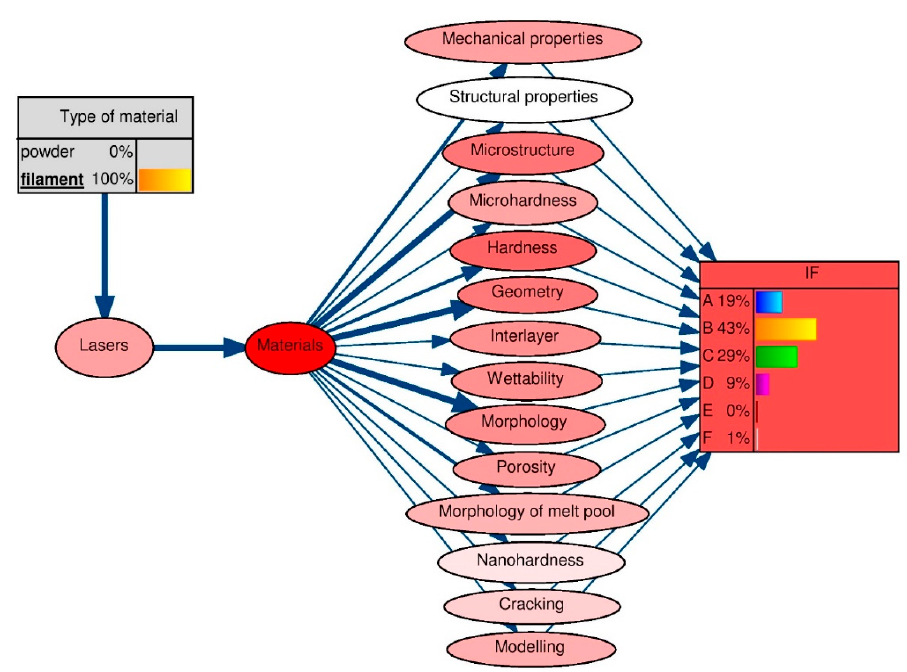
Figure 7. Expert knowledge levels of new technologies obtained via investigations into single-track features in laser processing, for studies performed using filament materials using the IF—the impact factor of the journal in which the research article was published. The level of expert knowledge in the journal with a specific IF index was: A = 19% (IF ≤ 2), B = 43% (2 < IF ≤ 3), C = 29% (3 < IF ≤ 4), D = 9% (4 < IF ≤ 5), E = 0% (5 < IF ≤ 6), F = 1% (IF > 6).